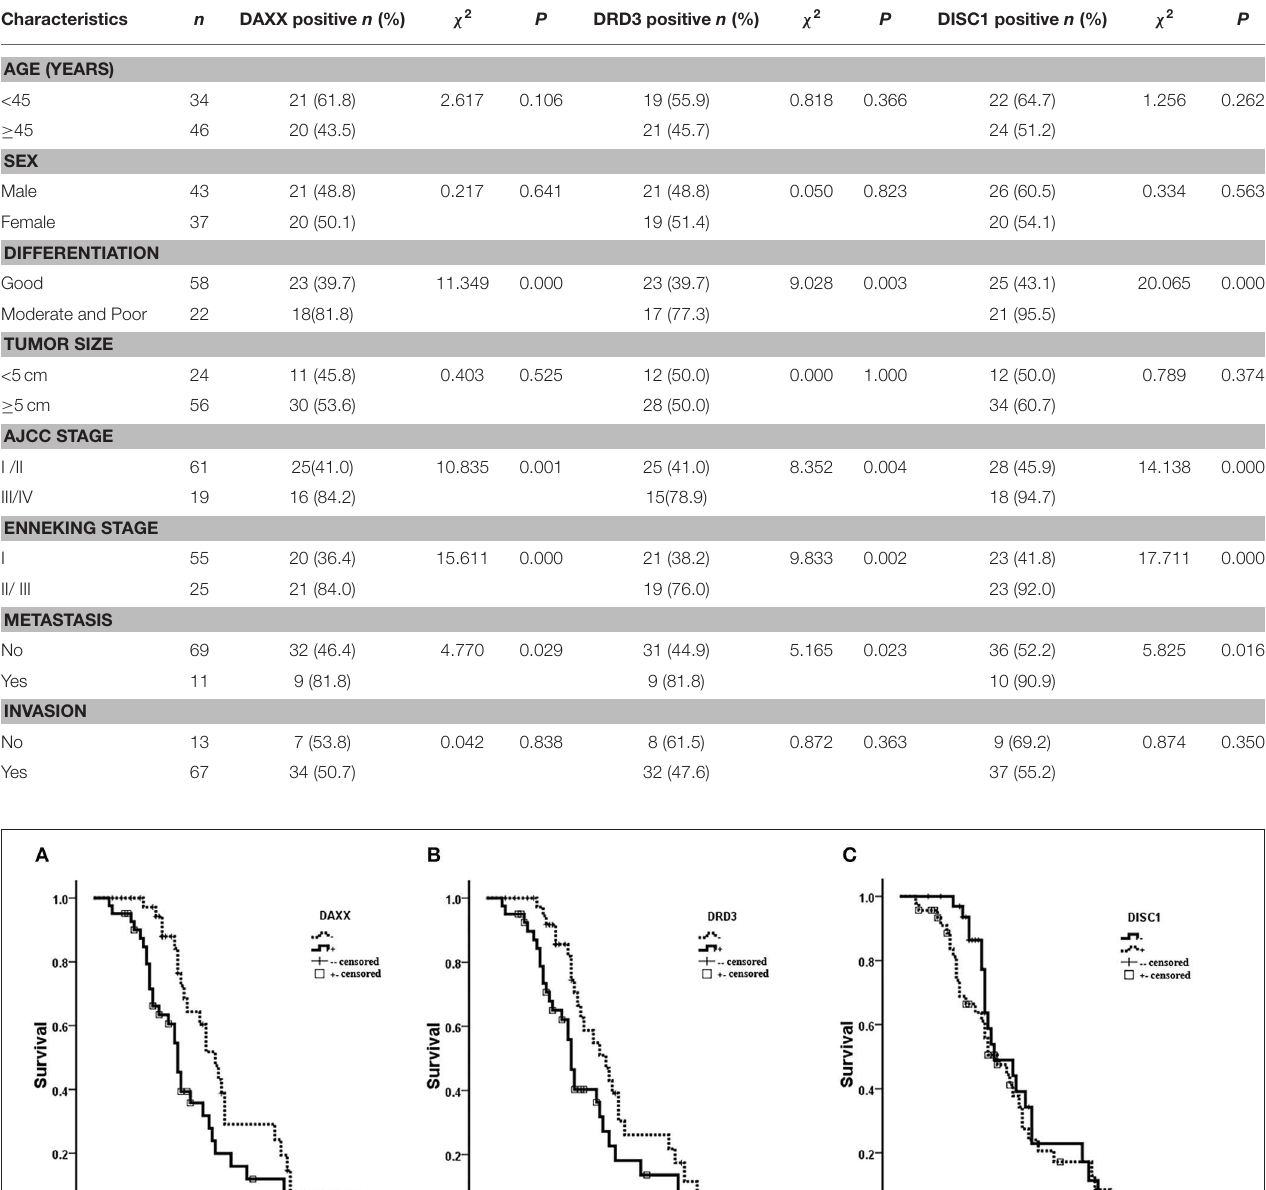
TABLE 2 | Associations of DAXX, DRD3, and DISC1 expression with the clinicopathological characteristics of chondrosarcoma. Characteristics